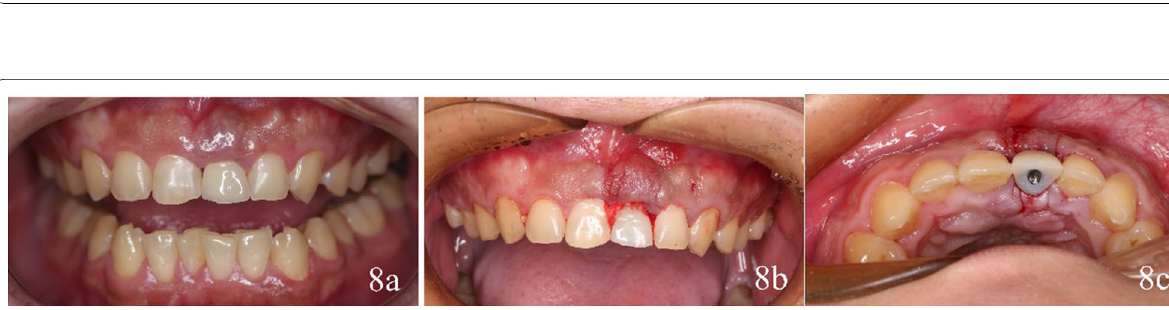
Fig. 7 Fabrication of implant-supported interim restoration based on designed implant position. ( a ) Alignment of digital data of interim abutment with the vital implant and implant scanning arm. b – e Design of implant-supported interim restoration based on selected virtual abutment. f Bonding the center of the buccal side of the crown with facing one side of the regular hexagon of the abutment. g Interim restoration milled